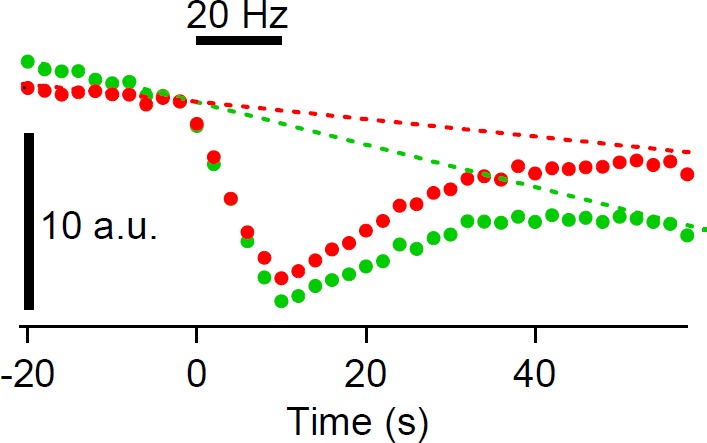
DOI:
http://dx.doi.org/10.7554/eLife.14643.016